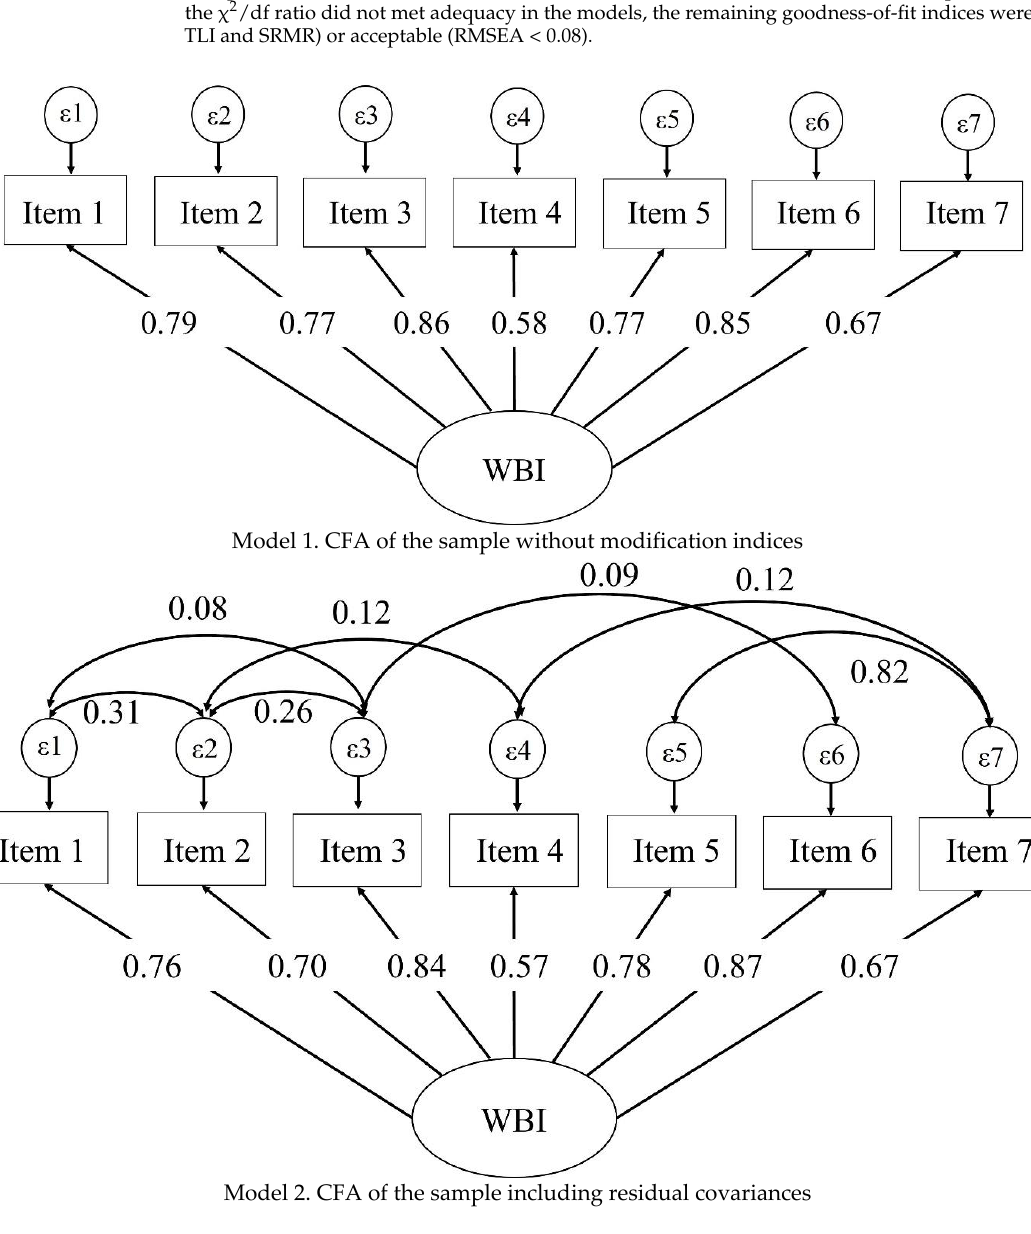
Figure 1. Confirmatory factor analysis of the total sample without modification indices ( Model 1 ) and after modification indices were added ( Model 2 ).